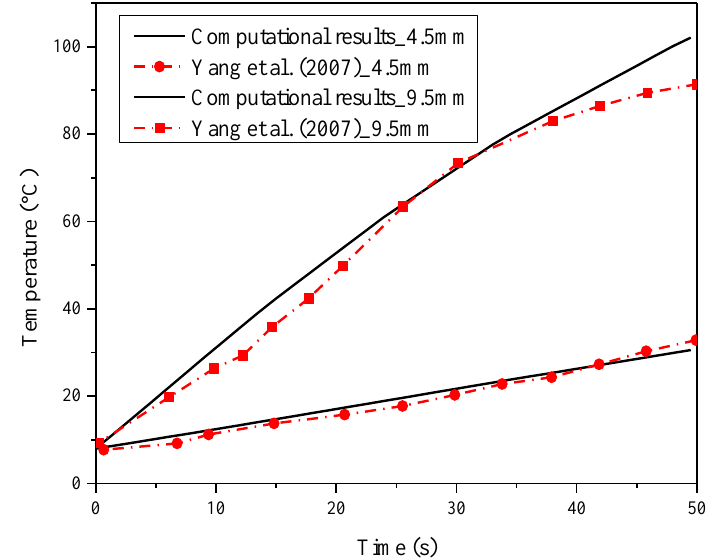
Figure 6. Validation of the temperature distribution in the tissue liver against the experimental data o ff ered by Yang et al. [36].